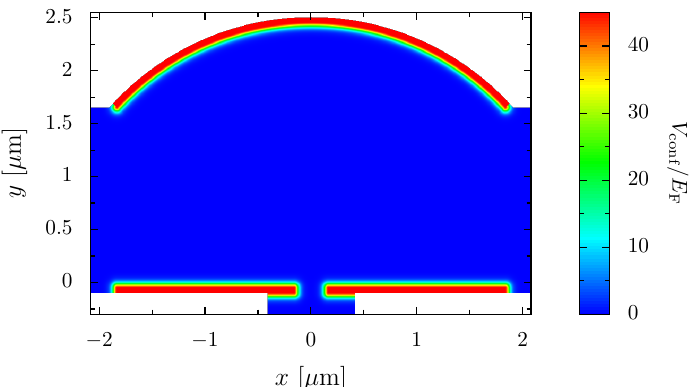
Figure 9: Confinement potential V (in units of the Fermi energy E ) with smooth conf F walls defining the geometry of Fig. 1 used for the quantum conductance calculations. White areas are not part of the system, equivalent to regions of infinite potential.